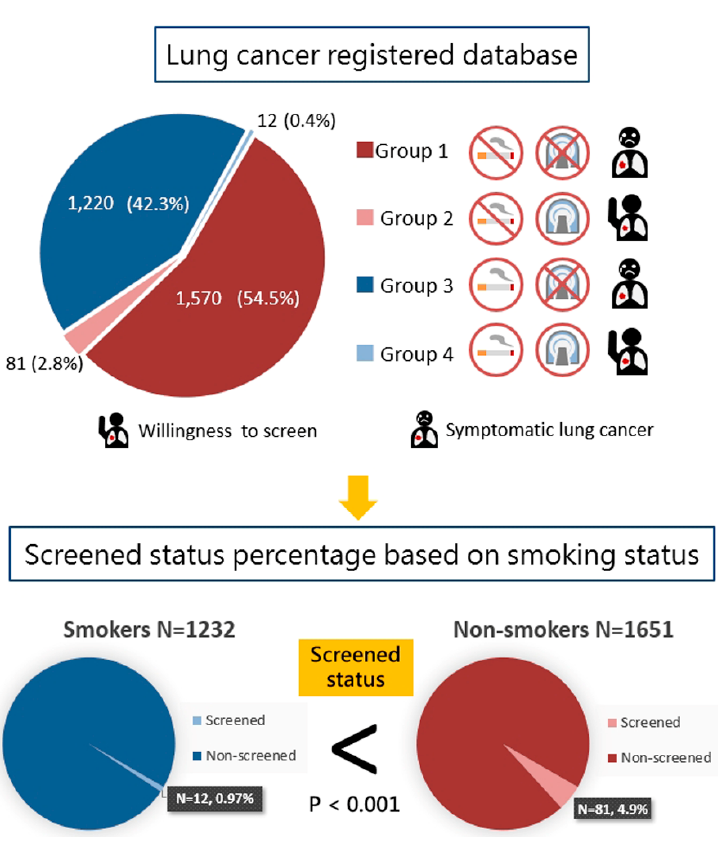
Figure 2. Screening status percentages according to lung cancer subjects based on smoking status.